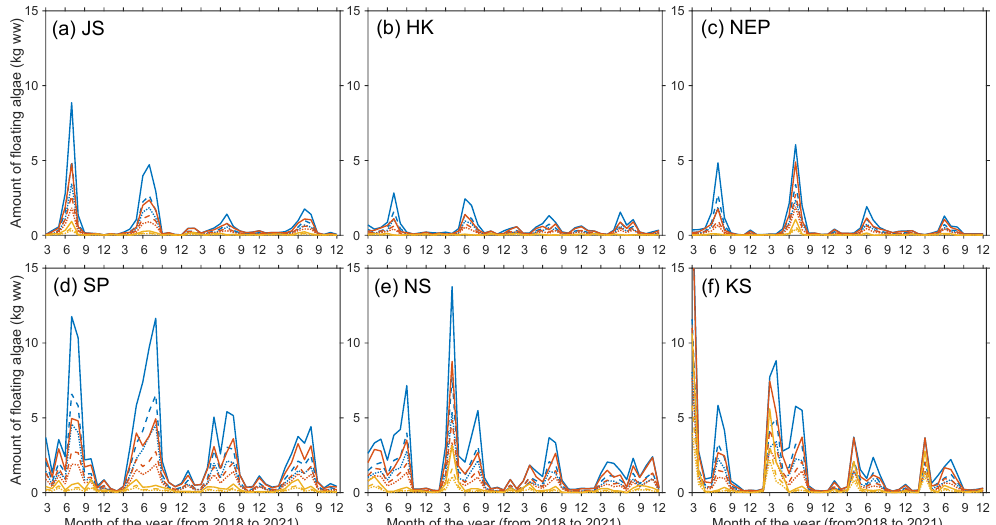
Figure 7. Monthly estimates of the floating macroalgae biomass detected outside continental shelves (deeper than 200 m) in each subarea shown in Figure 2. The colors and line style are identical to those in Figure